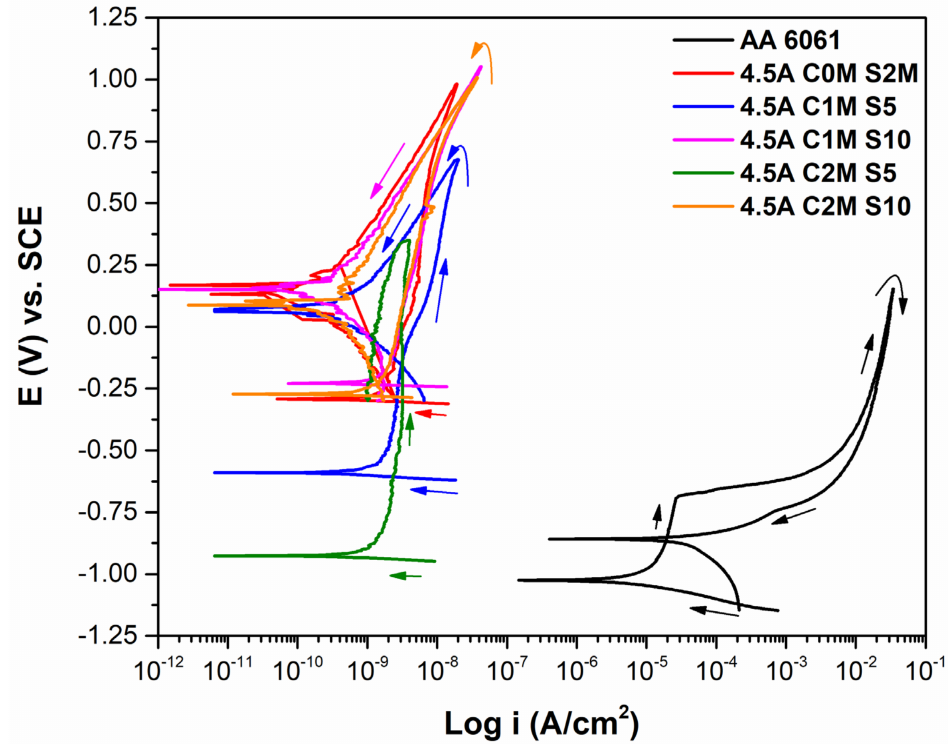
Figure 8. CPP curves of the AA6061 samples a 4.5 A/dm 2 in NaCl